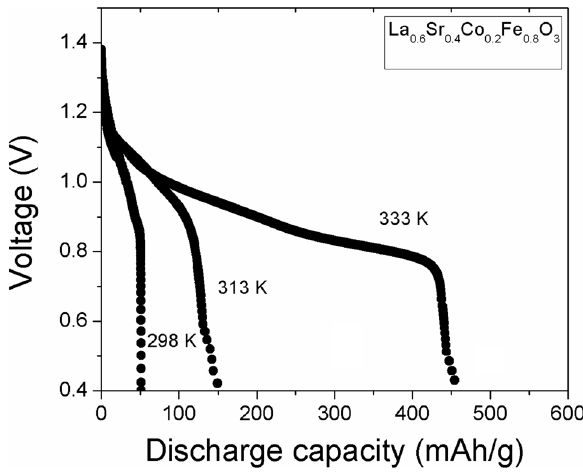
Fig. 4 Discharge capacity curves at 298, 313 and 333 K in KOH 6 M, respectively. (discharge current density of 125 mA g - 1 )